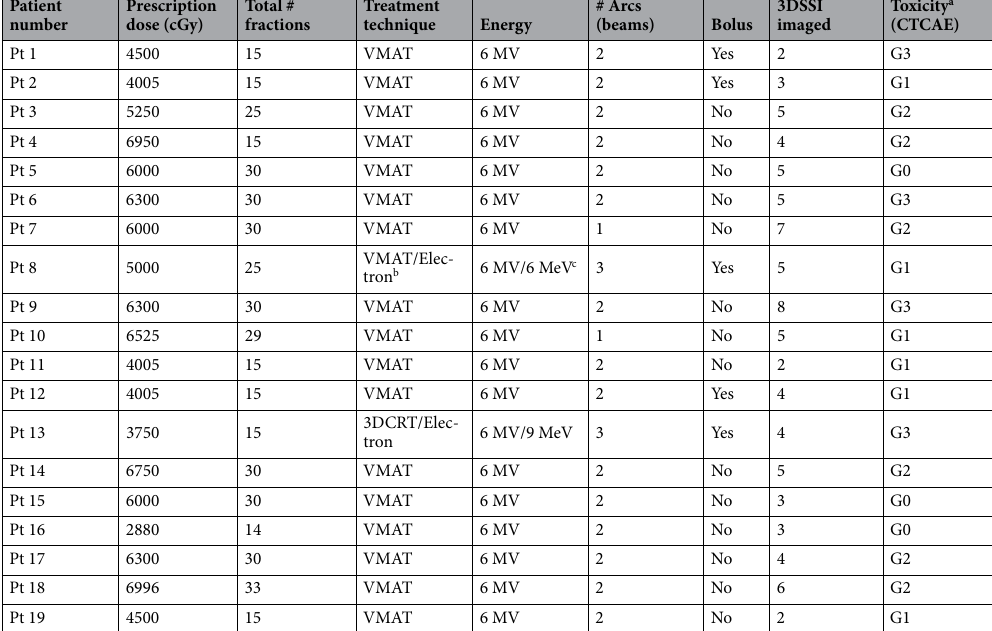
Table 2. Patient treatment specifications and skin toxicity. VMAT volumetric- modulated arc therapy, 3DCRT three-dimensional conformal radiotherapy, 3DSSI 3D skin surface image, CTCAE Common Terminology Criteria for Adverse Events. a Radiation dermatitis was graded according to the CTCAE v4.0. b Combination of VMAT and electron irradiation. c 6 MV photon and 6 MeV Electron